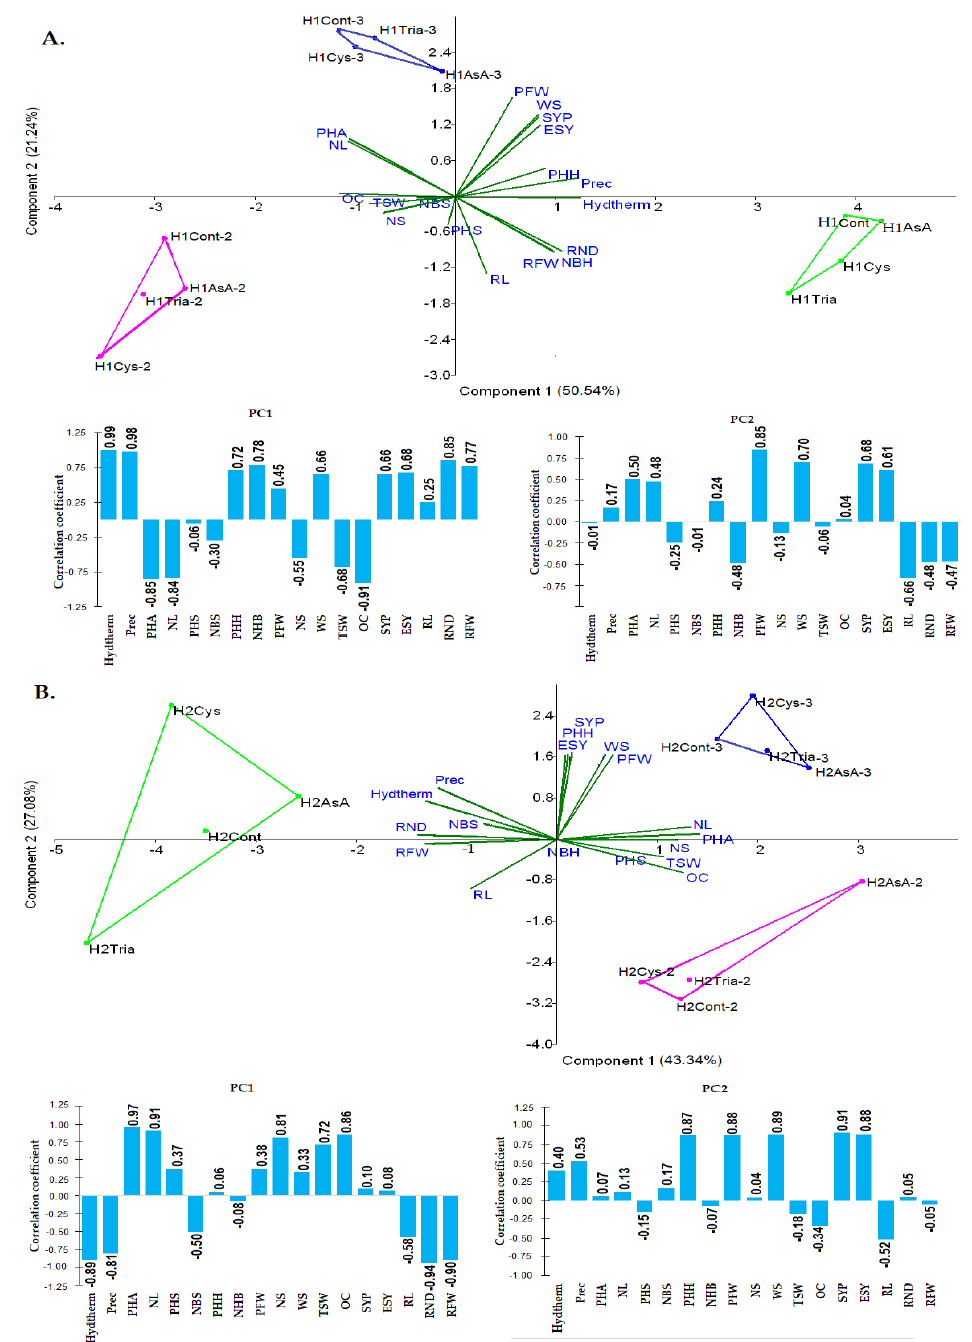
Figure 2. Principal Components Analyses (PCA) was performed to correlate the hydrothermal index (Hydtherm) and average rainfall (Prec), as environmental variables, with the assessed parameters and growing seasons (AsA-, Cys-, Tria-, Cont-I. growing season; AsA_2, Cys_2, Tria_2, Cont_2-II. grooving season); (AsA_3, Cys_3, Tria_3, Cont_3-III. grooving season) at H1 ( A ) and H2 canola cultivars ( B ). In the case of H1, hydrothermal index and average rainfall positively correlated with PHH, SYP, ESY, WS, PFW, RND, and RFW. Negative correlations could be observed between weather conditions and the following parameters: OC, PHA, NL, TSW, and NS. In the case of H2, the negatively correlated parameters with the average rainfall and the hydrothermal index were RND, RFW, RL, and NBS, whereas the positively correlated ones were SYP, ESY, WS, PHH, and PFW.